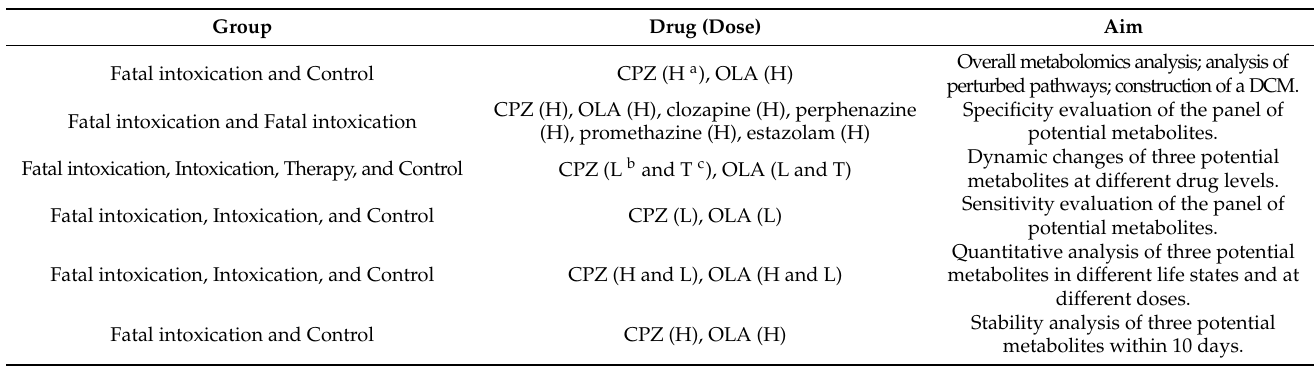
Table 1. Information of study